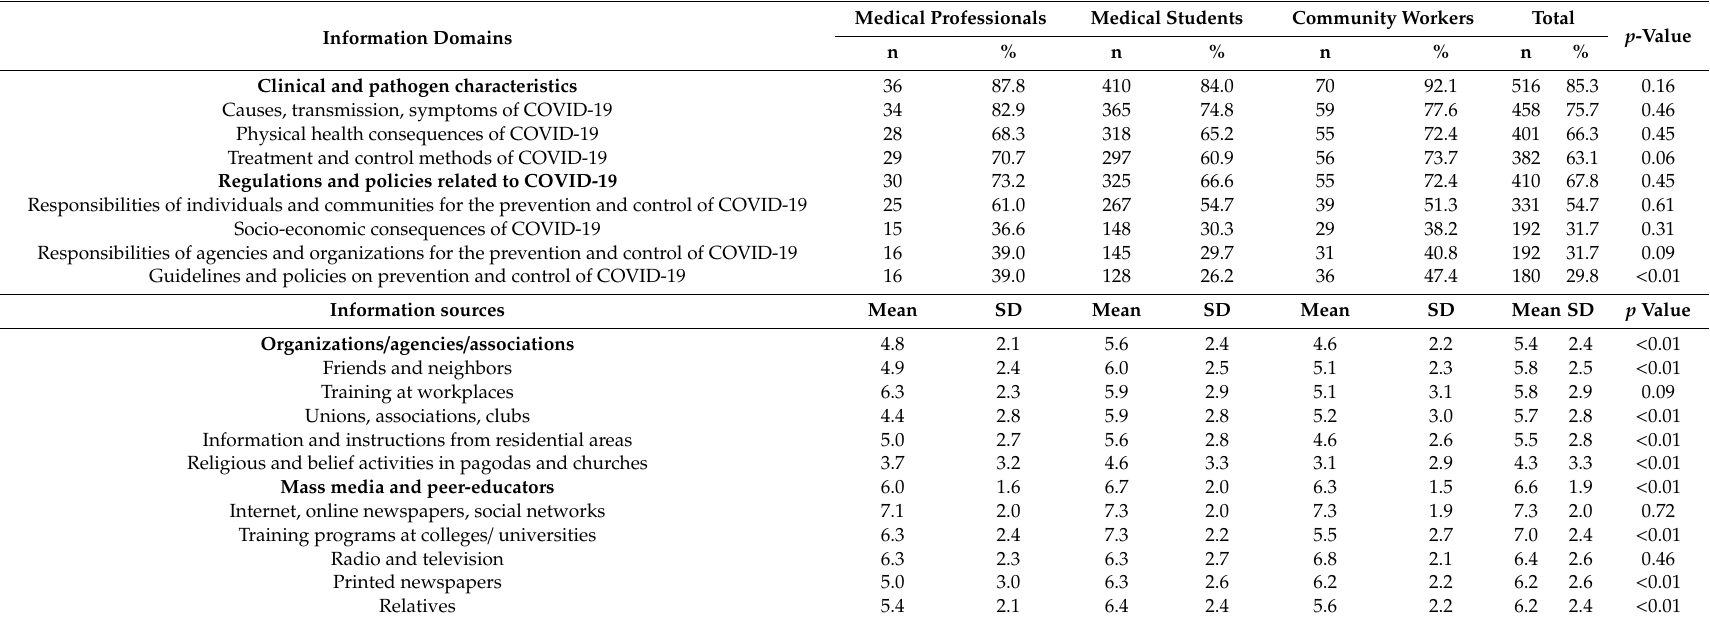
Table 4. Contents regarding COVID-19 and frequency of accessing among